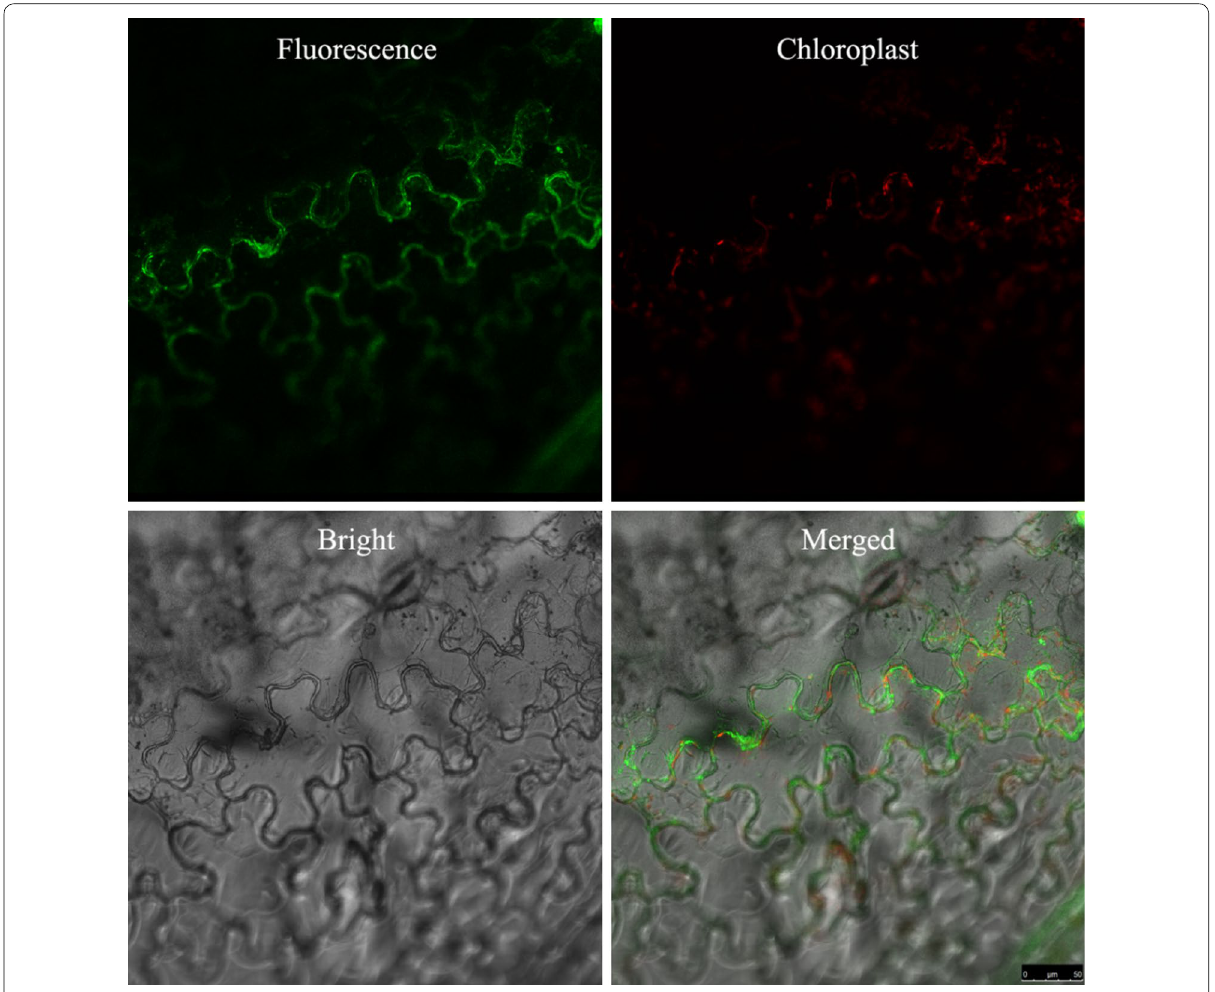
Fig. 4 Sub-cellular localization of AMEP412 in tobacco